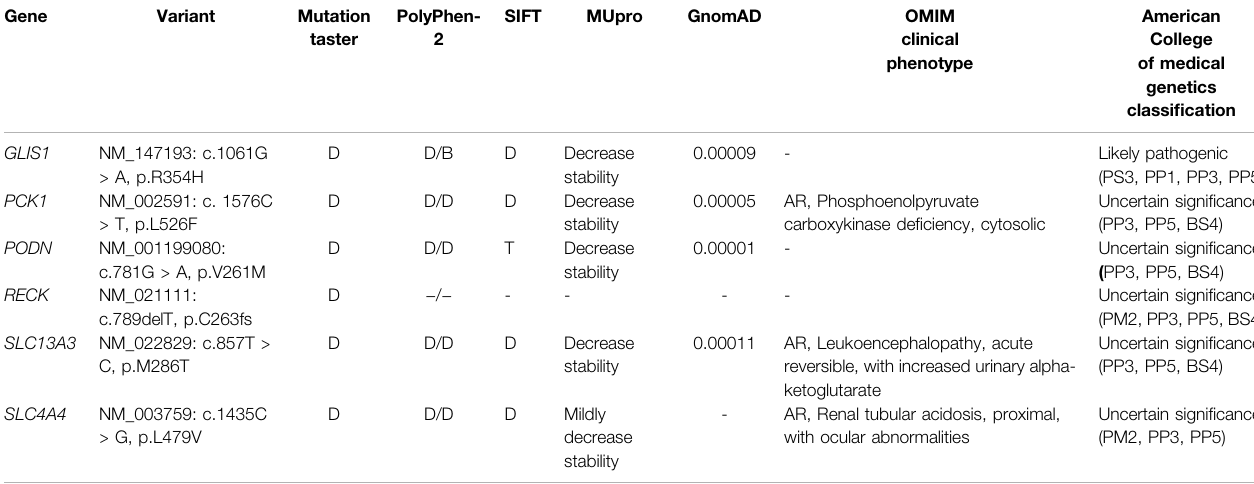
TABLE 2 | Overlapping variants identi fi ed in PPD001 family by